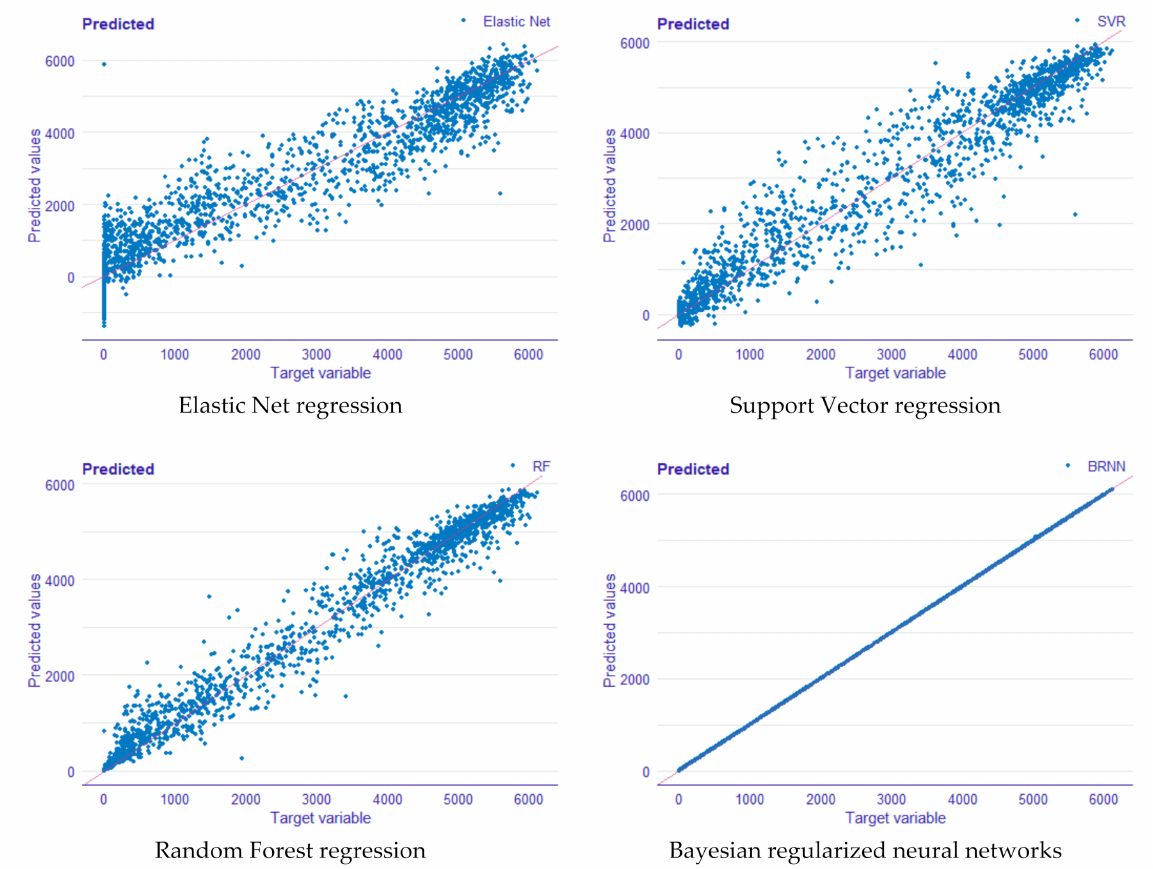
Figure 4. Scatterplots: predicted versus observed values